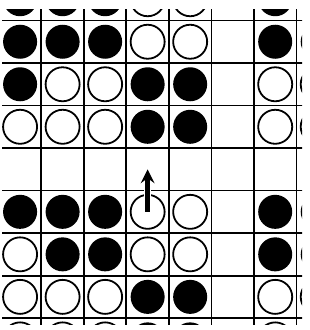
Figure 11. Corner’s WHITE moves horizontally.